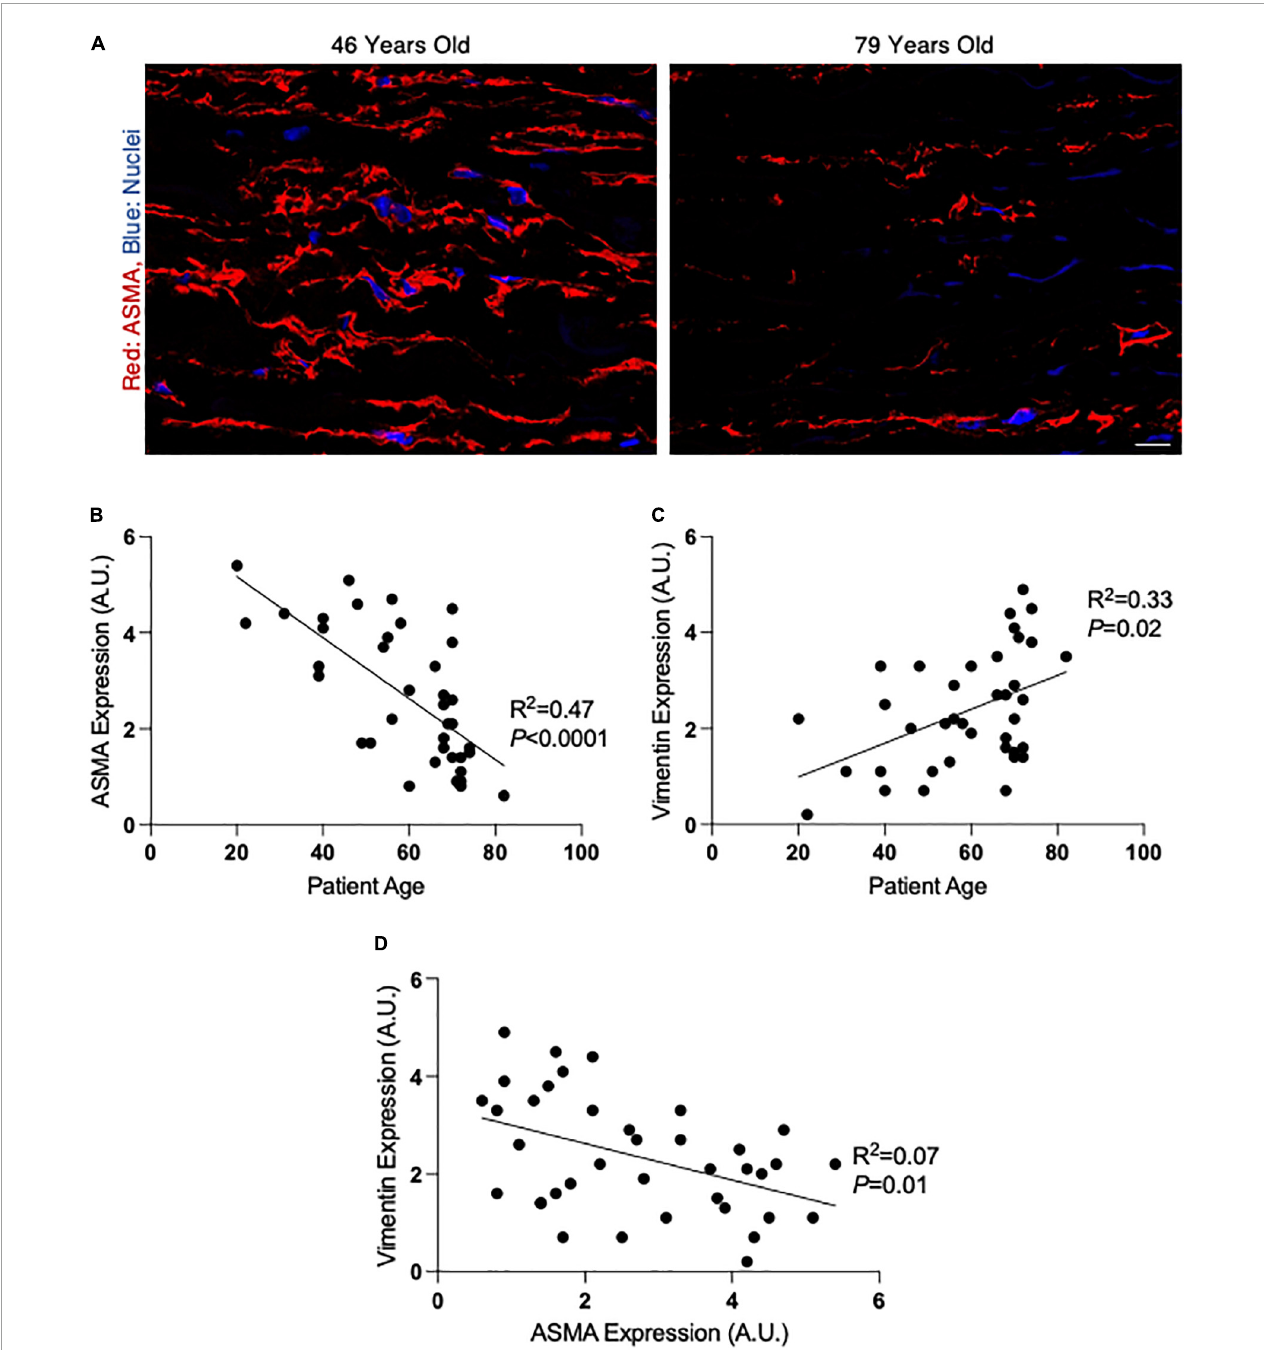
FIGURE1 Alpha-smooth muscle actin (ASMA) decreases and vimentin increases with age in non-dilated ascending aortas. (A) Fluorescent micrographs of ascending aortic cross-sections from a 46 year old (left) and 79 year old (right) patient. Red, ASMA; blue, nuclei. Scalebar = 20 µ m. (B,C) Graphs depicting the linear relationship between patient age and ASMA (B) or Vimentin (C) expression in non-dilated aortic tissue. (D) Graph depicting the relationship between ASMA and vimentin expression in non-dilated aortic tissue. A.U., arbitrary units; expression values were calculated by measuring fluorescence